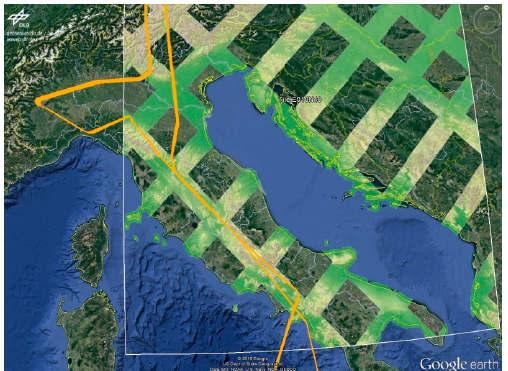
Figure 2. Map overlay of available SRTM/X-SAR (shuttle radar topography mission/X-band synthetic aperture radar) digital elevation model data (stripes inside the box) matching the CHARM-F flight path (orange lines) in Central Italy. © 2016 Google, © DLR/ASI 2010.